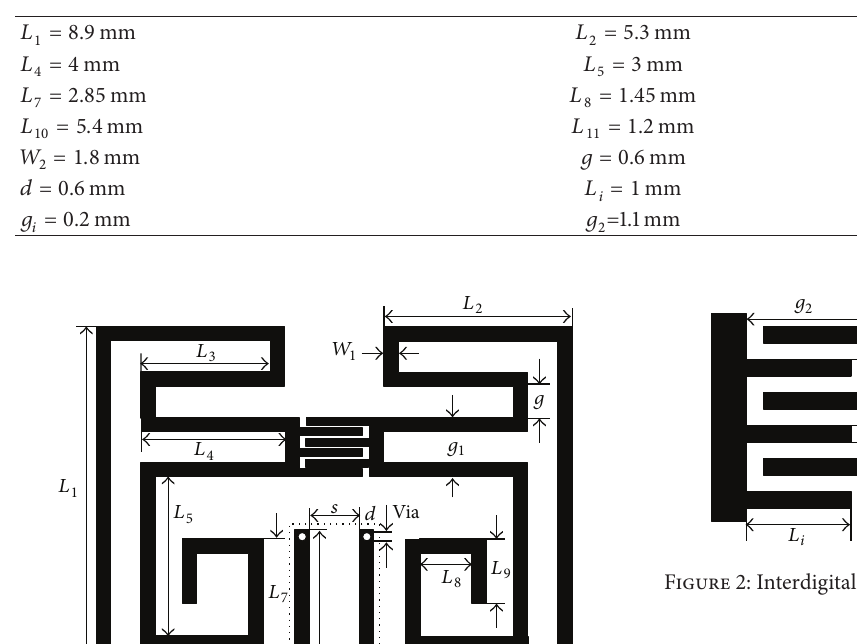
Table 1: Dimensions of the proposed filter (unit: mm).